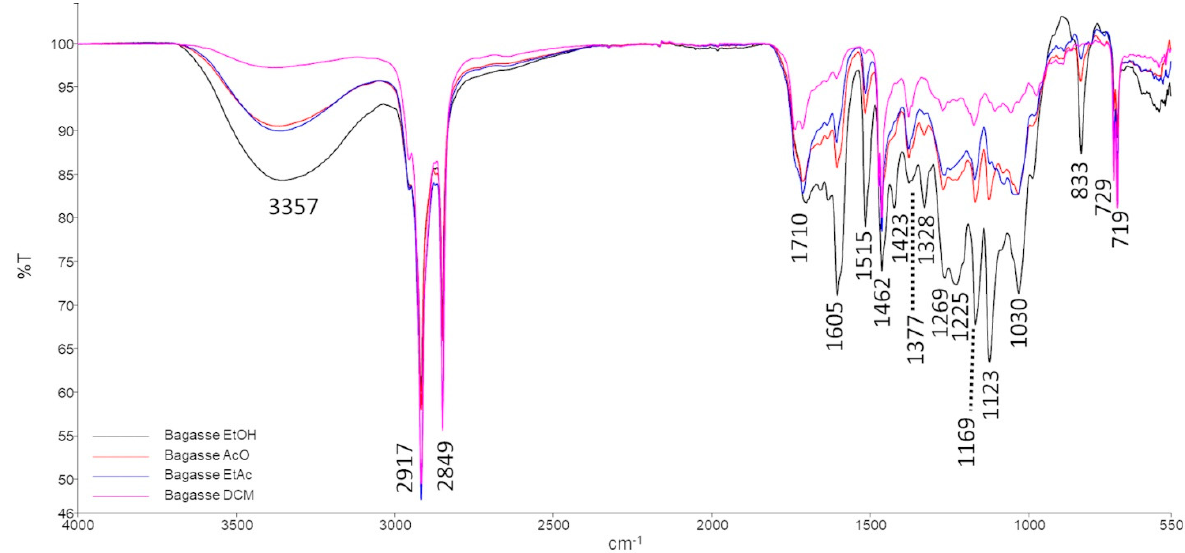
Figure 4. FTIR spectra of bagasse extracts. Table 5. FTIR frequencies interpretation table .